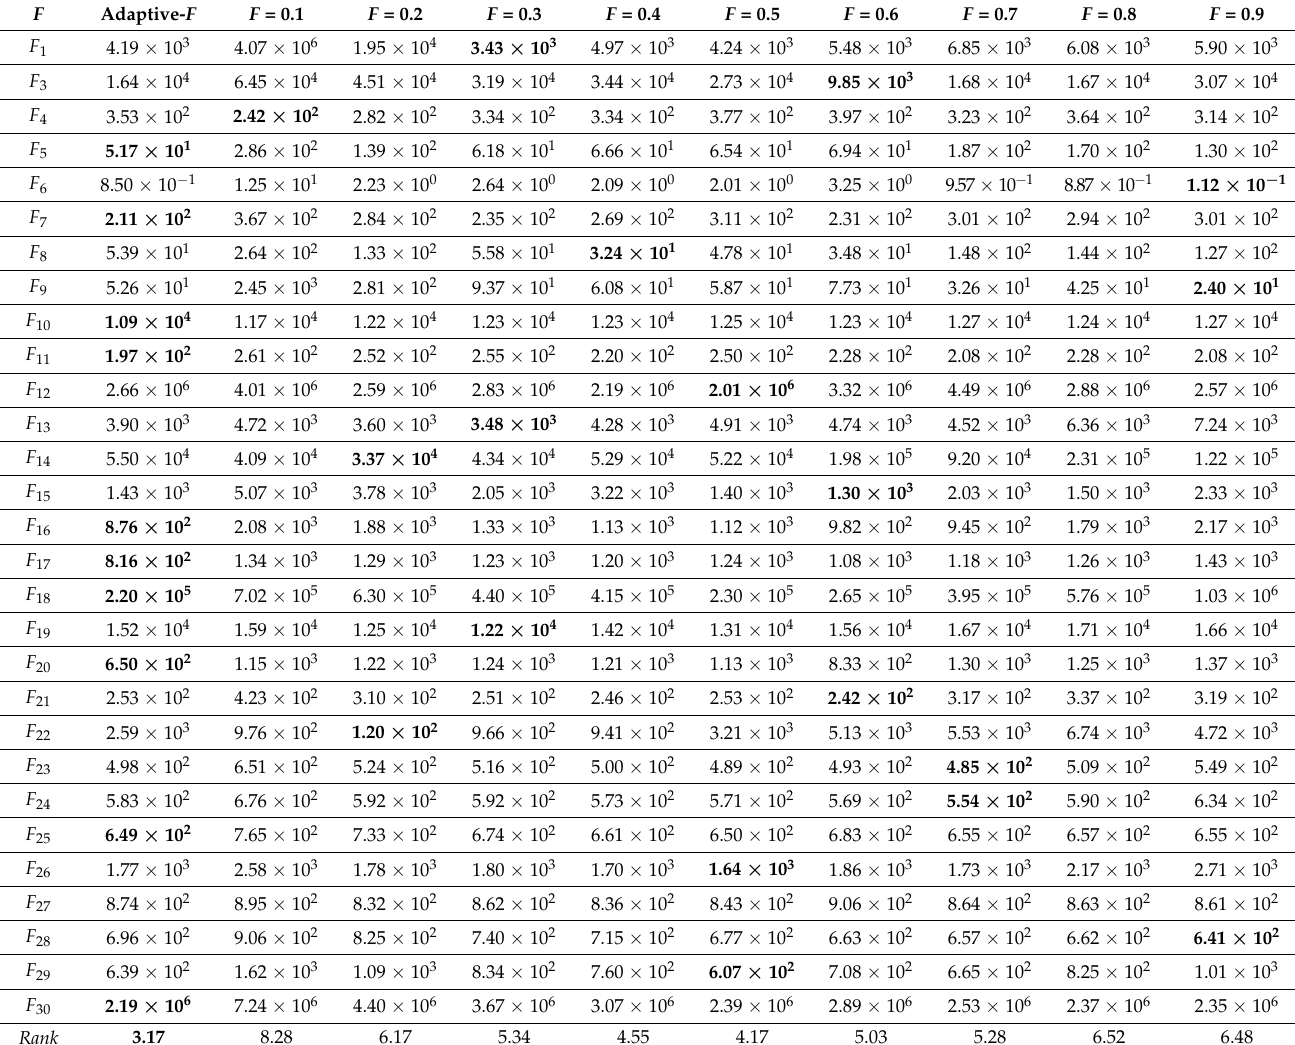
Table 8. Comparison results between PCLPSO with and without the adaptive strategy for F on the 50- D CEC 2017 benchmark